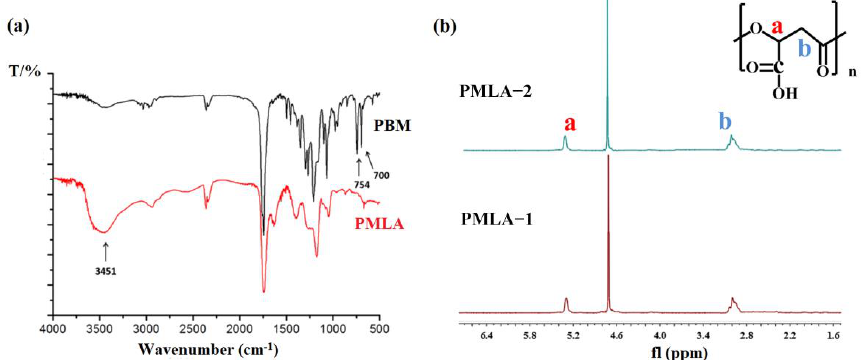
Figure 8. Structural characterization of PMLA. ( a ) FTIR spectrum; ( b ) 1 H NMR spectrum.